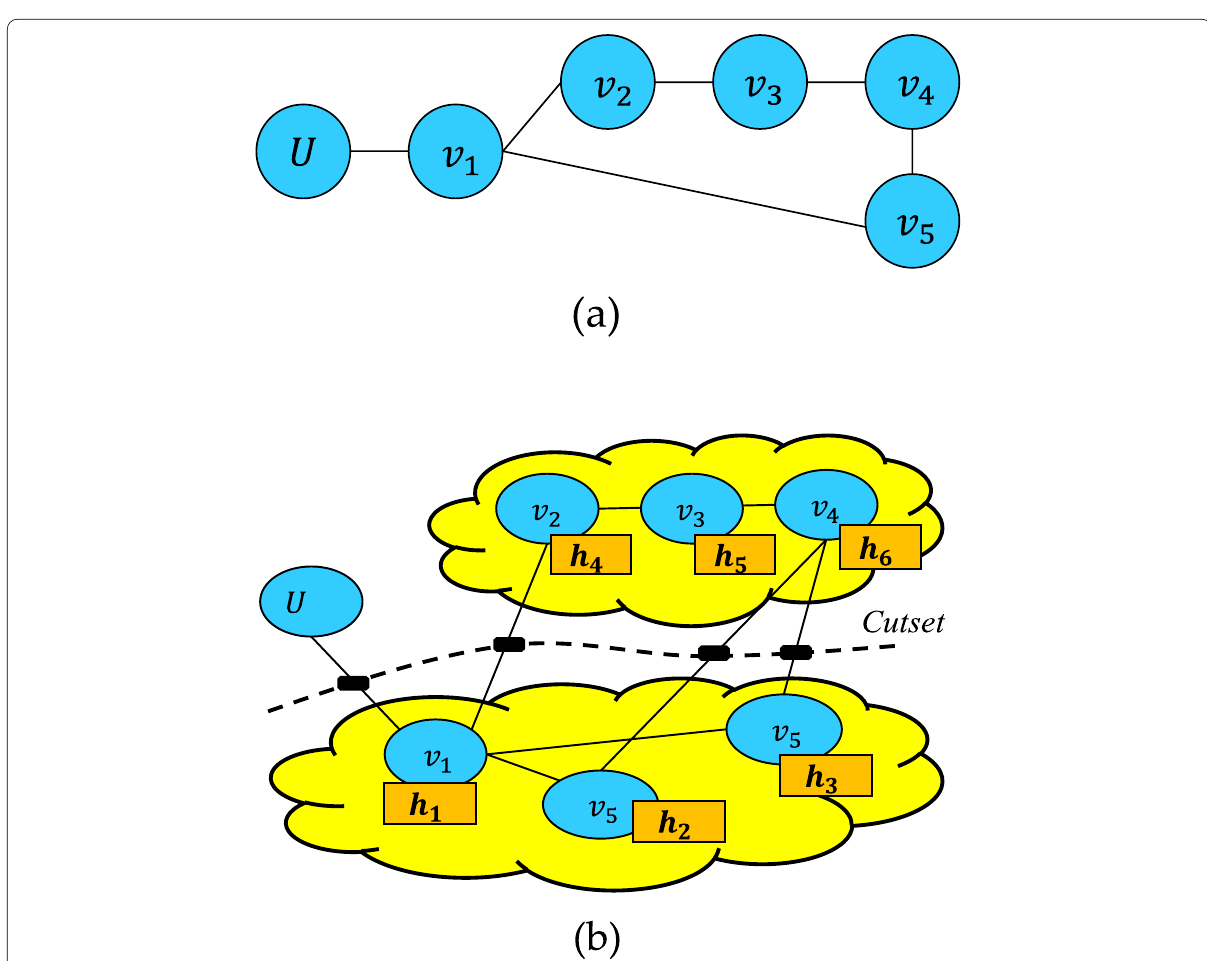
Fig. 1 An application and its deployment. a Application Graph: U represents the Users, vertex v i represents a deployable unit (task), and an edge represents calls between tasks. b Deployment: host h j represents a CPU and the cutset weight is the number of interactions between